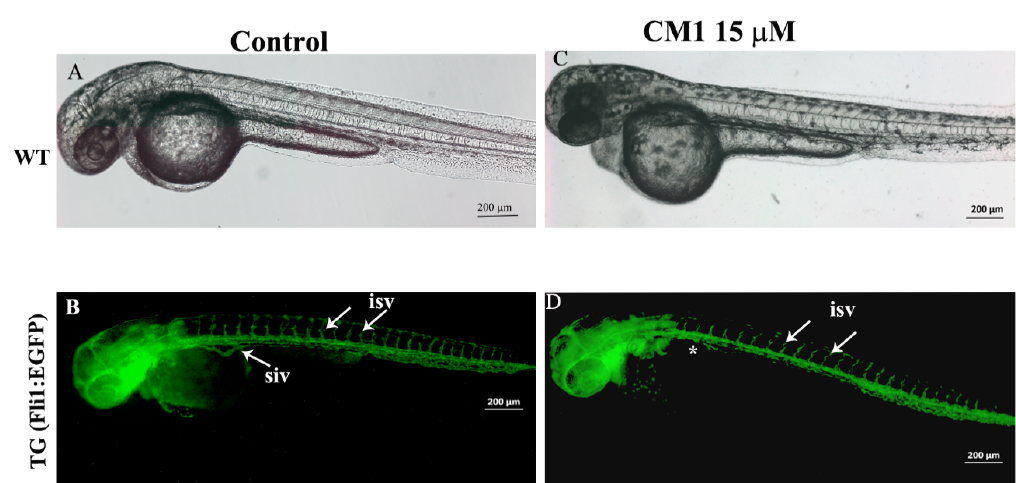
Figure 5. 2-methoxyfuranodiene inhibited the secondary angiogenic blood vessel formation in zebrafish embryos. ( A ) Bright field image of a Tg(fli1:EGFP) embryo that was exposed to 0.1% methanol as a control. The embryos developed normally. ( B ) The fluorescent image of a Tg (fli1: EGFP) embryo at 72 hpf. The green color indicates all the blood vessels. The white arrows show the inter-segmental blood vessels in the trunk of the mock-treated zebrafish embryo, which were the first angiogenic blood vessels that formed at around 48 hpf. The emergence of the second angiogenic blood vessels can be seen on the trunk of the control embryo. ( C ) The bright field image of a Tg (fli1: EGFP) embryo treated with 10 µ M of CM1. The bright field image shows the normal development of the embryos. ( D ) The fluoresce image of a Tg (fli1: EGFP) zebrafish embryo treated with 15 µ M of CM1 showed the normal formation of the inter-segmental blood vessels. However, the treated embryos do not have the sub-intestinal vein blood vessels (indicated by white